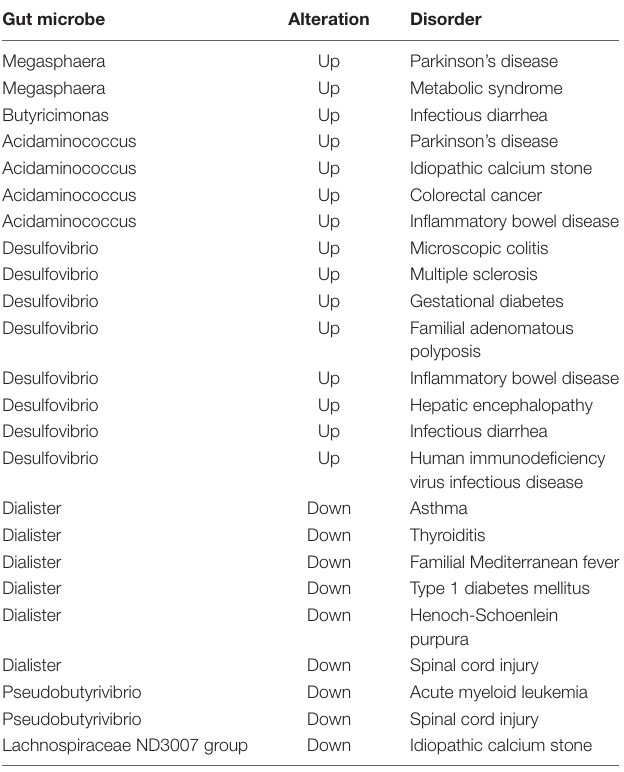
TABLE 2 | The gut microbes associated with AMI have the same pattern of change as other diseases searched in the gutMDisoeder database. Gut microbe